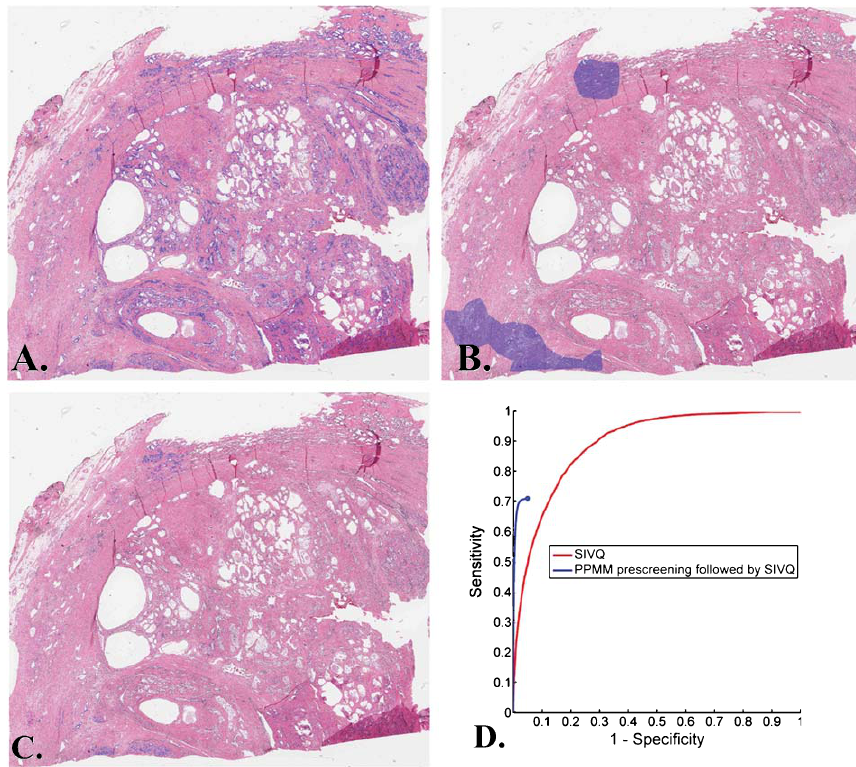
Fig. 2. SIVQ, PPMM, PPMM-SIVQ analysis of sample #1. Using SIVQ, a ring vector was selected to identify the prostatic epithelium. The resultant thresholded heatmap is shown in Panel A. Nearly all the epithelium was identified. The same specimen was then analyzed with PPMM. The resultant thresholded heatmap is shown in Panel B. PPMM identified 2 out of the 3 cancer foci. The algorithm cascade of PPMM followed by SIVQ was then used to analyze the specimens. The malignant epithelium within 2 of the 3 cancer were identified and annotated in Panel